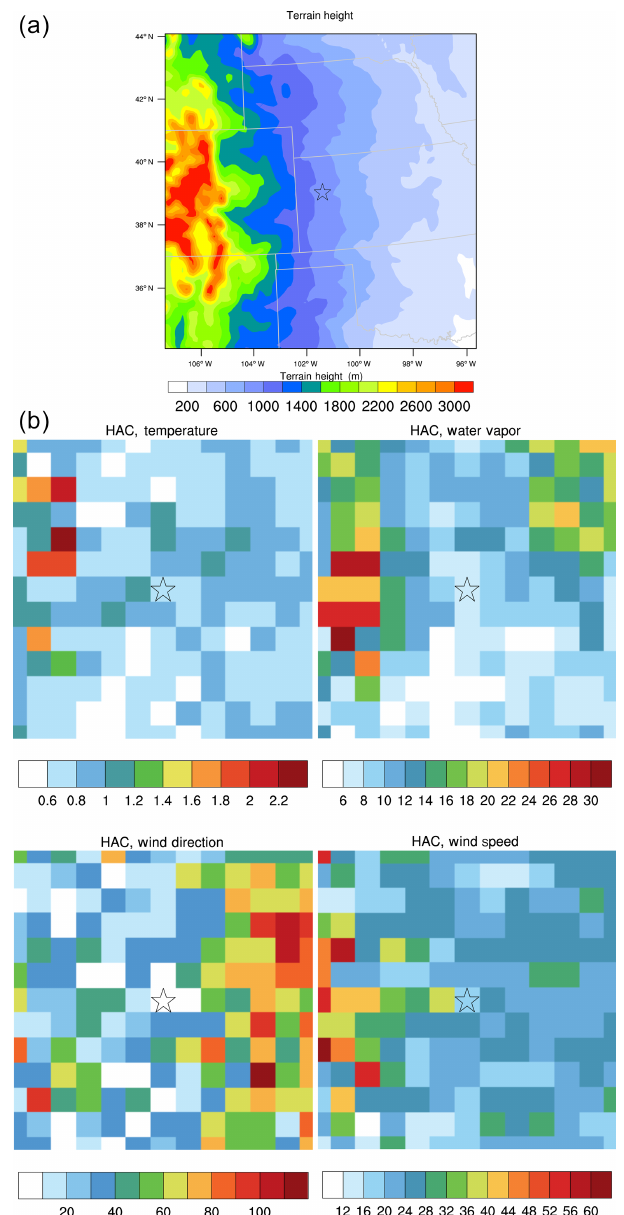
Figure 8. (a) Terrain height (in meters) over the tested area; (b) nor- malized RMSEs in percent (relative to their corresponding obser- vations) of HAC-predicted temperature, water vapor mixing ratio, wind direction, and speed at midnight in January. The star shows where the DNNs are developed (Logan, Kansas).